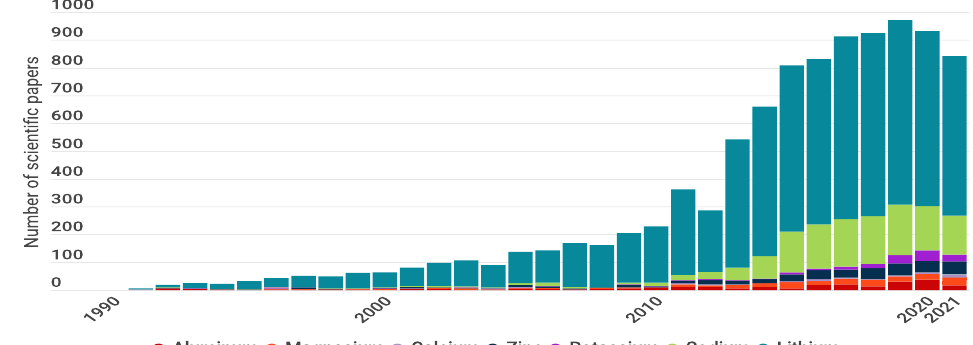
Figure 6. Publications per year about negative electrodes, comparing seven battery types: Li, Na, K, Zn, Ca, Mg, and Al. Graph constructed by the authors. Data from Web of